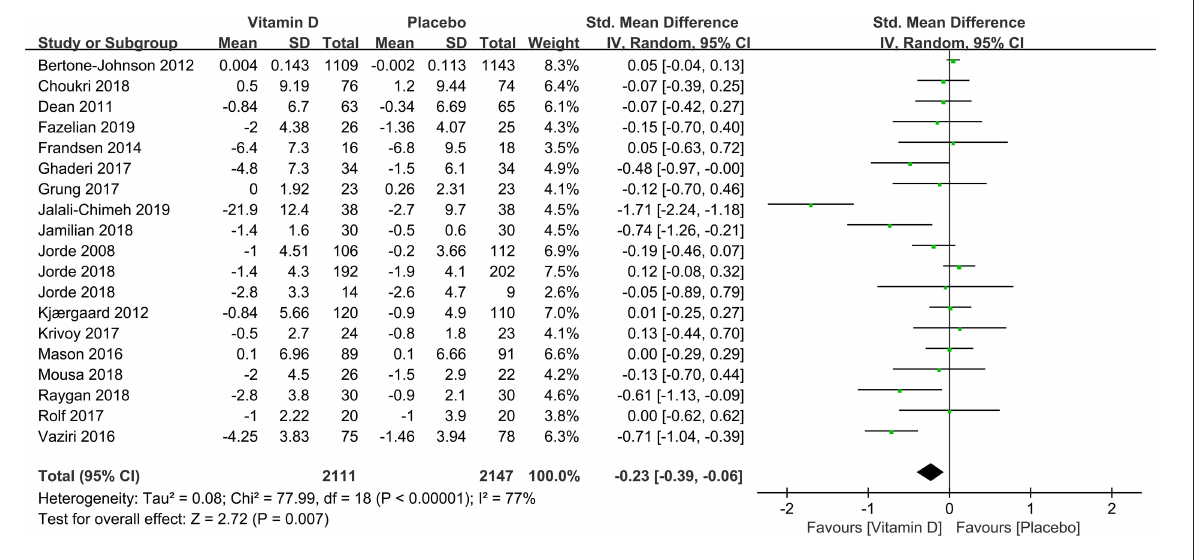
FIGURE2 Forest plot of the correlation between vitamin D and the incidence of